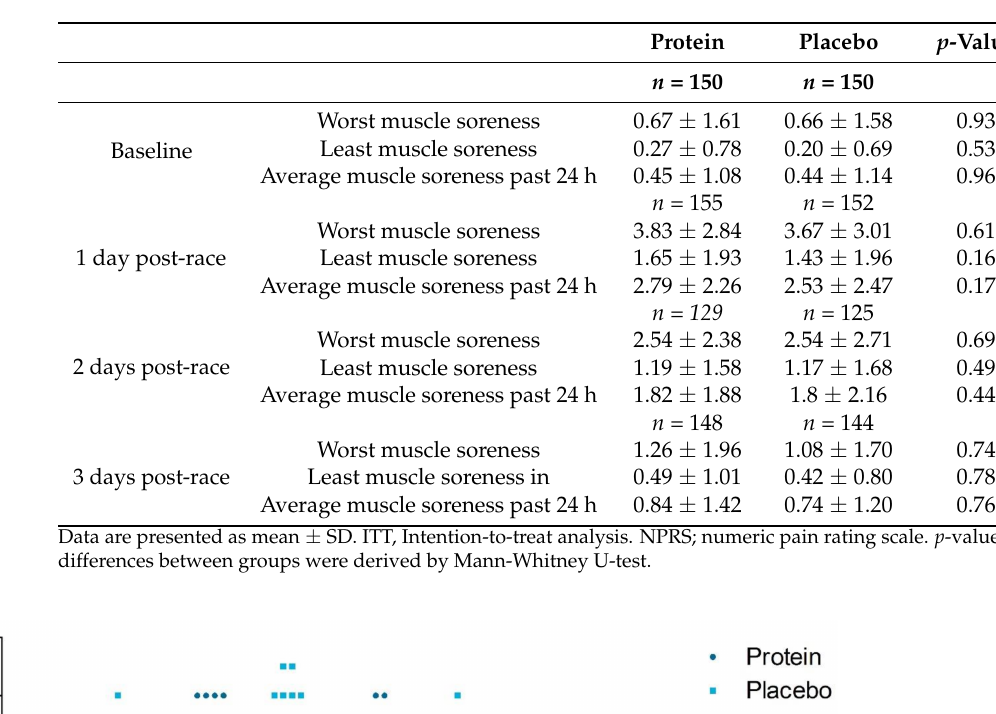
Table 3. Baseline and post-race NPRS scores for perceived lower extremity muscle soreness, based on ITT.